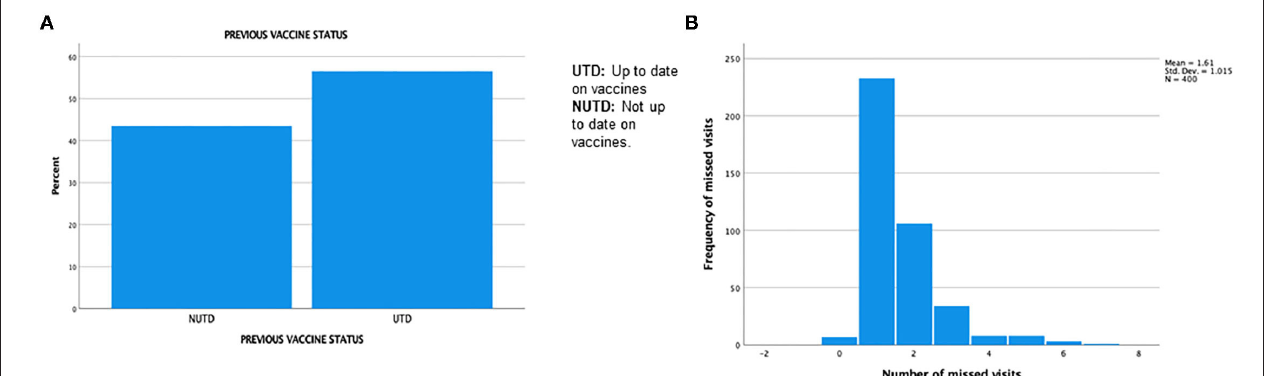
FIGURE 4 | (A) Previous vaccine status. (B) Number of missed clinic